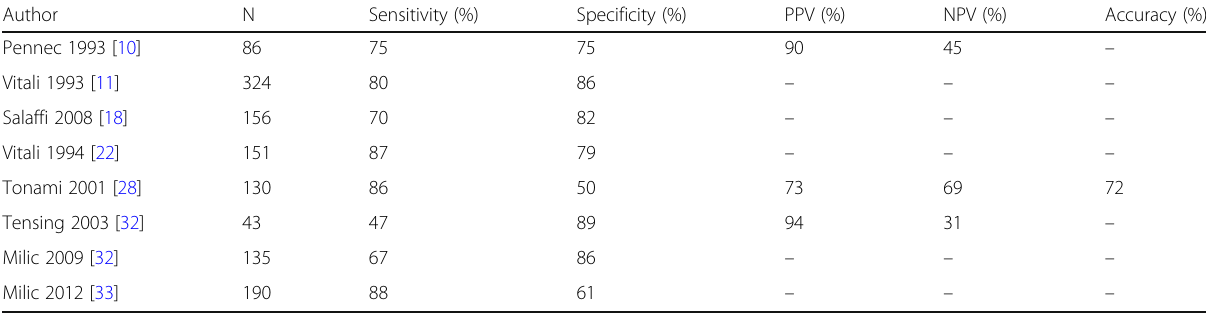
Table 4 Scintigraphy for the diagnosis of SS